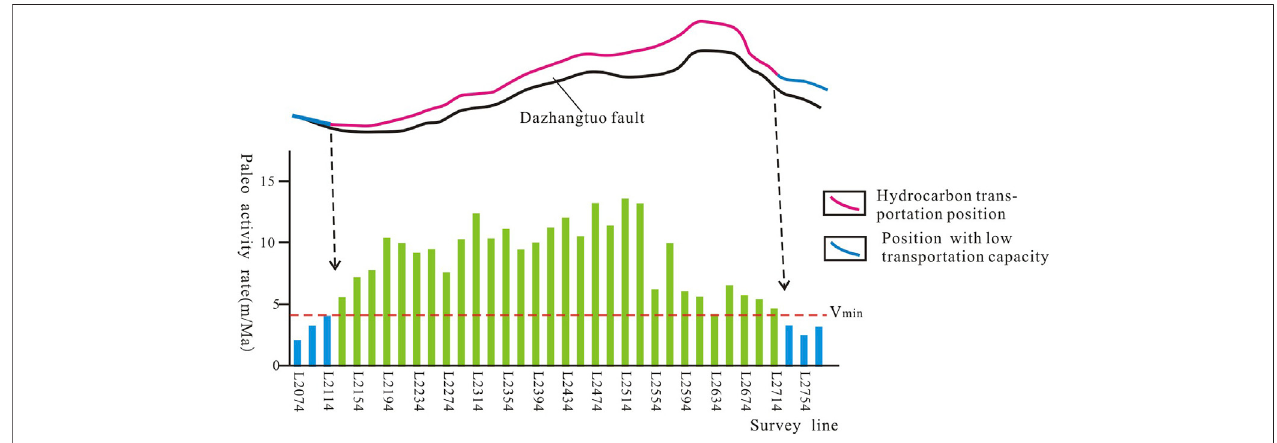
FIGURE 6 | Determination of hydrocarbon transportation position along the Dazhangtuo fault.